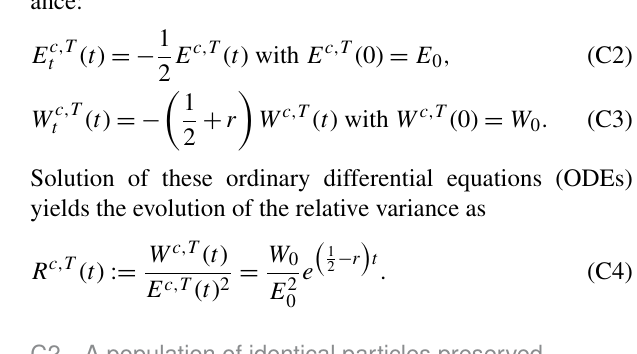
Figure A1. Abrasion rate E d predicted by the compound kernel (Eq. 3) fitted to experimental data in Attal and Lavé (2009). Fig- ure 9a by Attal and Lavé (2009) superposed with our model fits F 1 and F 2 . Mass estimated from diameter. Least squares optimization yields r = 0 . 19 and c 12 = 0 .